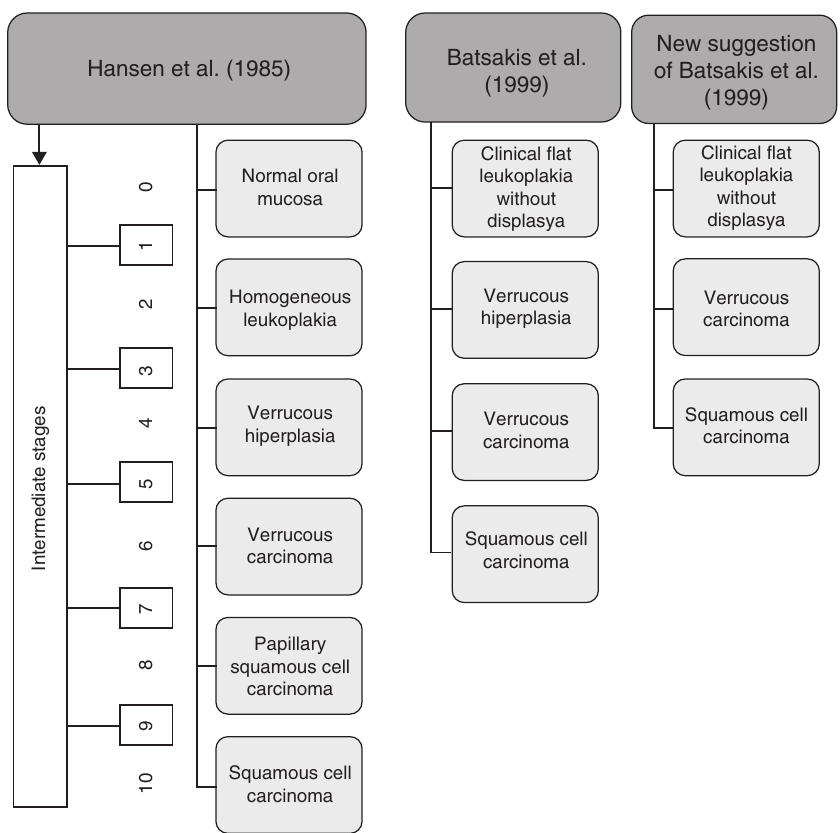
Histologic stages of progression to carcinoma. Adapted from Ghazali et al. (2003).